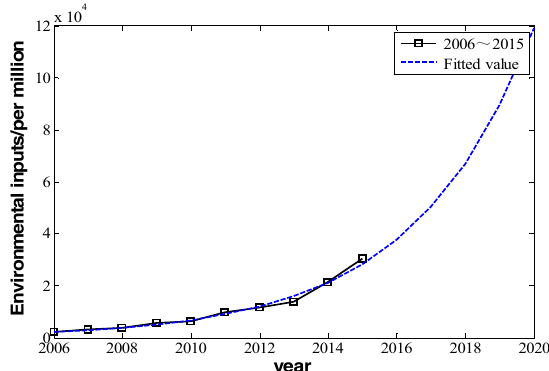
Figure 5. The actual value and predicted value of environmental input in 2006 to